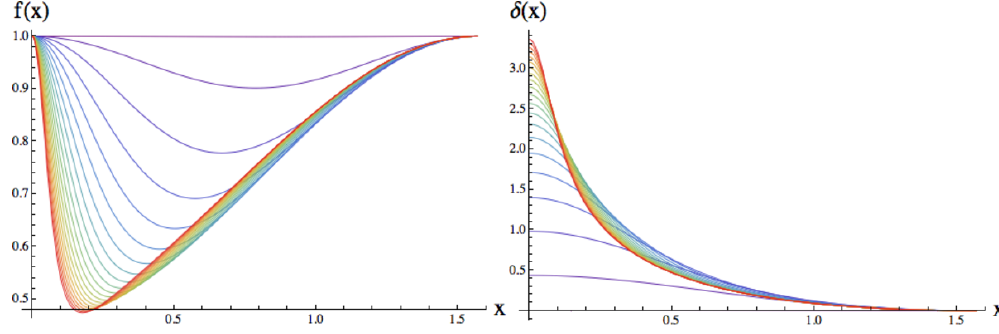
Figure 1 . Pumping solutions for (cid:11) o 2 [0 ; 20], the color frequency grows with growing (cid:11) o .